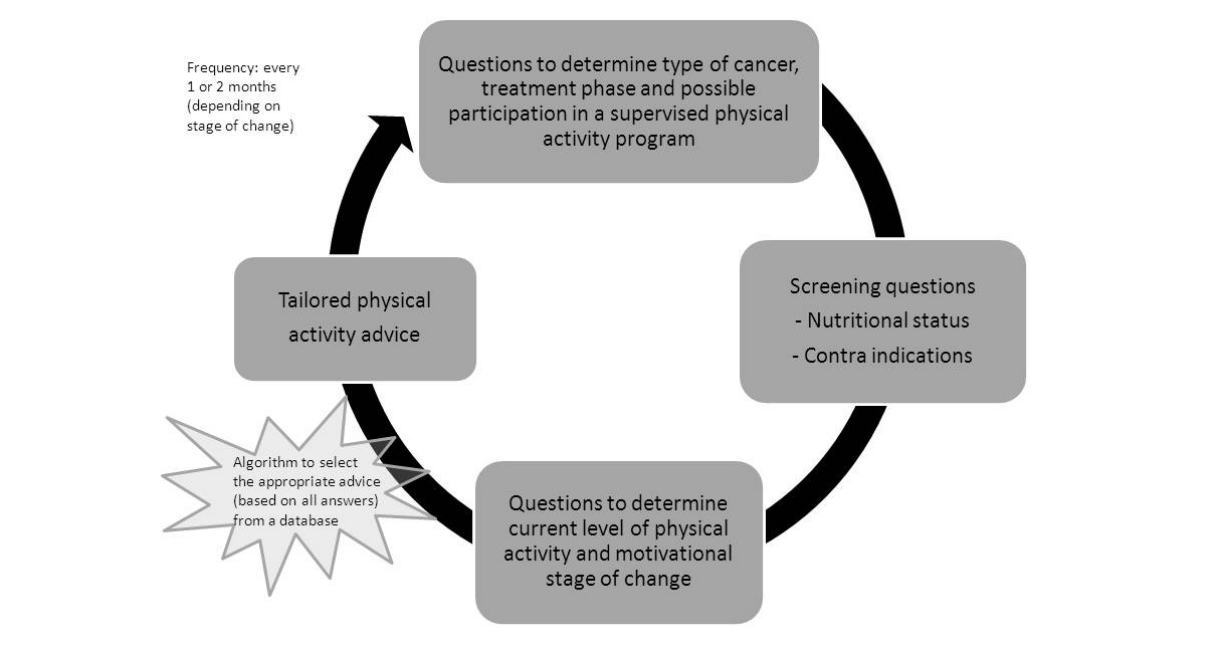
Figure 3. Interactive feature of MijnAVL: physical activity support